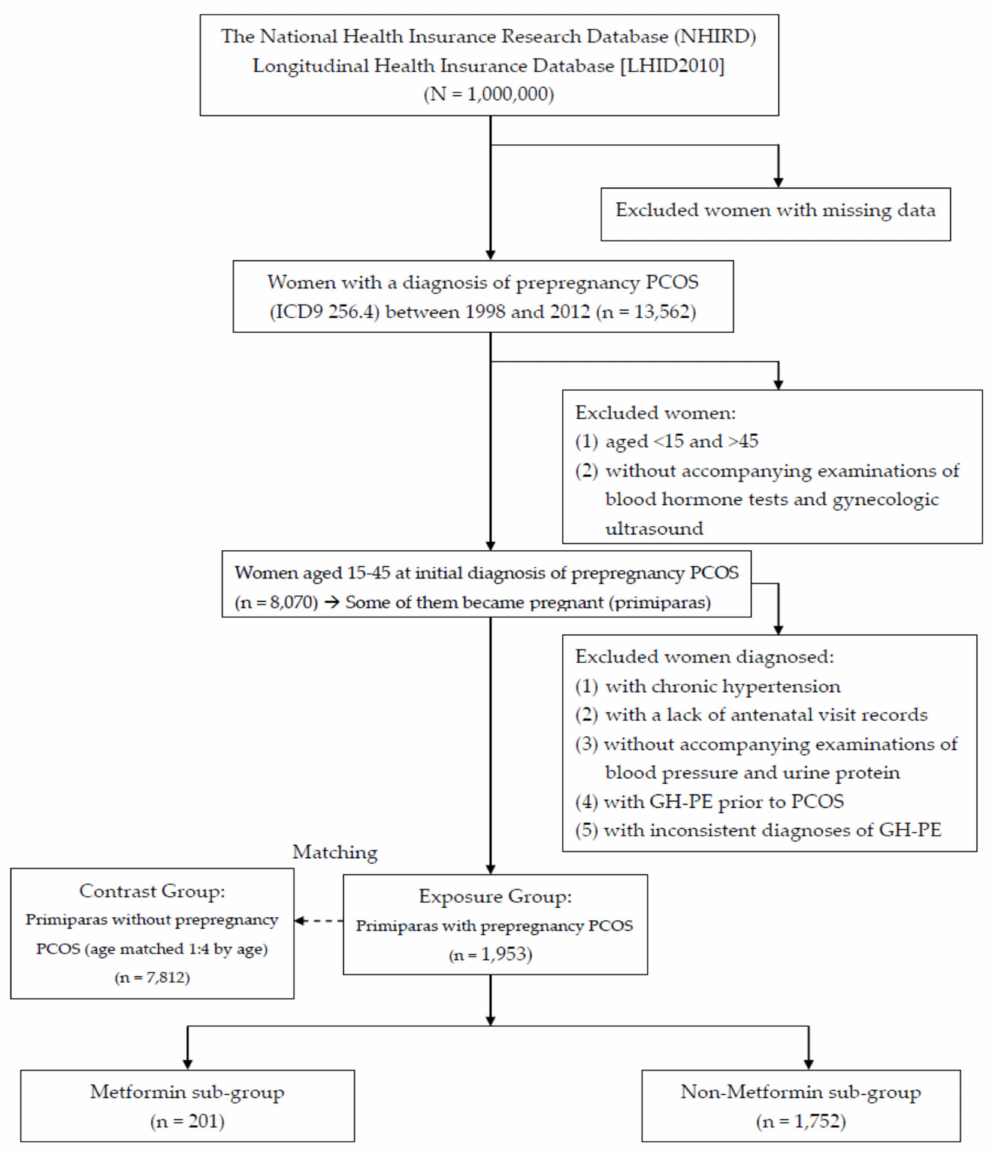
Figure 1. The flow chart of case inclusion and exclusion of women with prepregnancy polycystic ovary syndrome